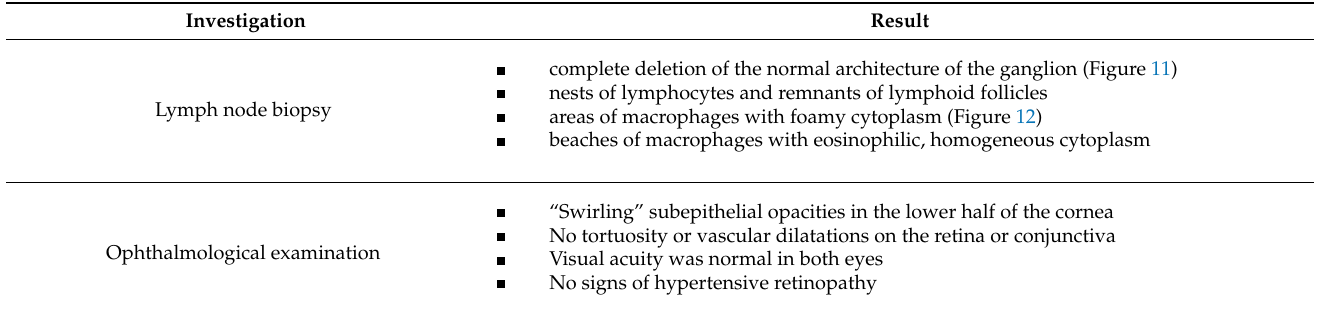
Table 3. Other investigations.